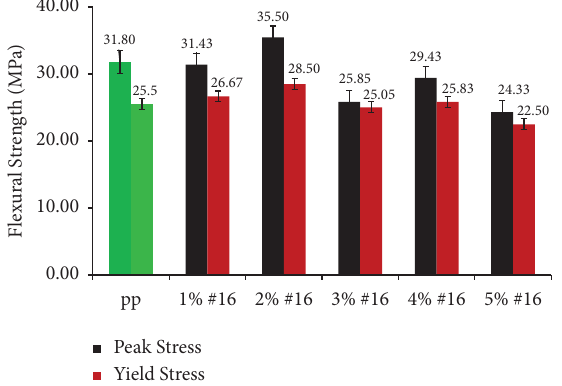
Figure 1: Peak and yield stresses for pure PP and #16